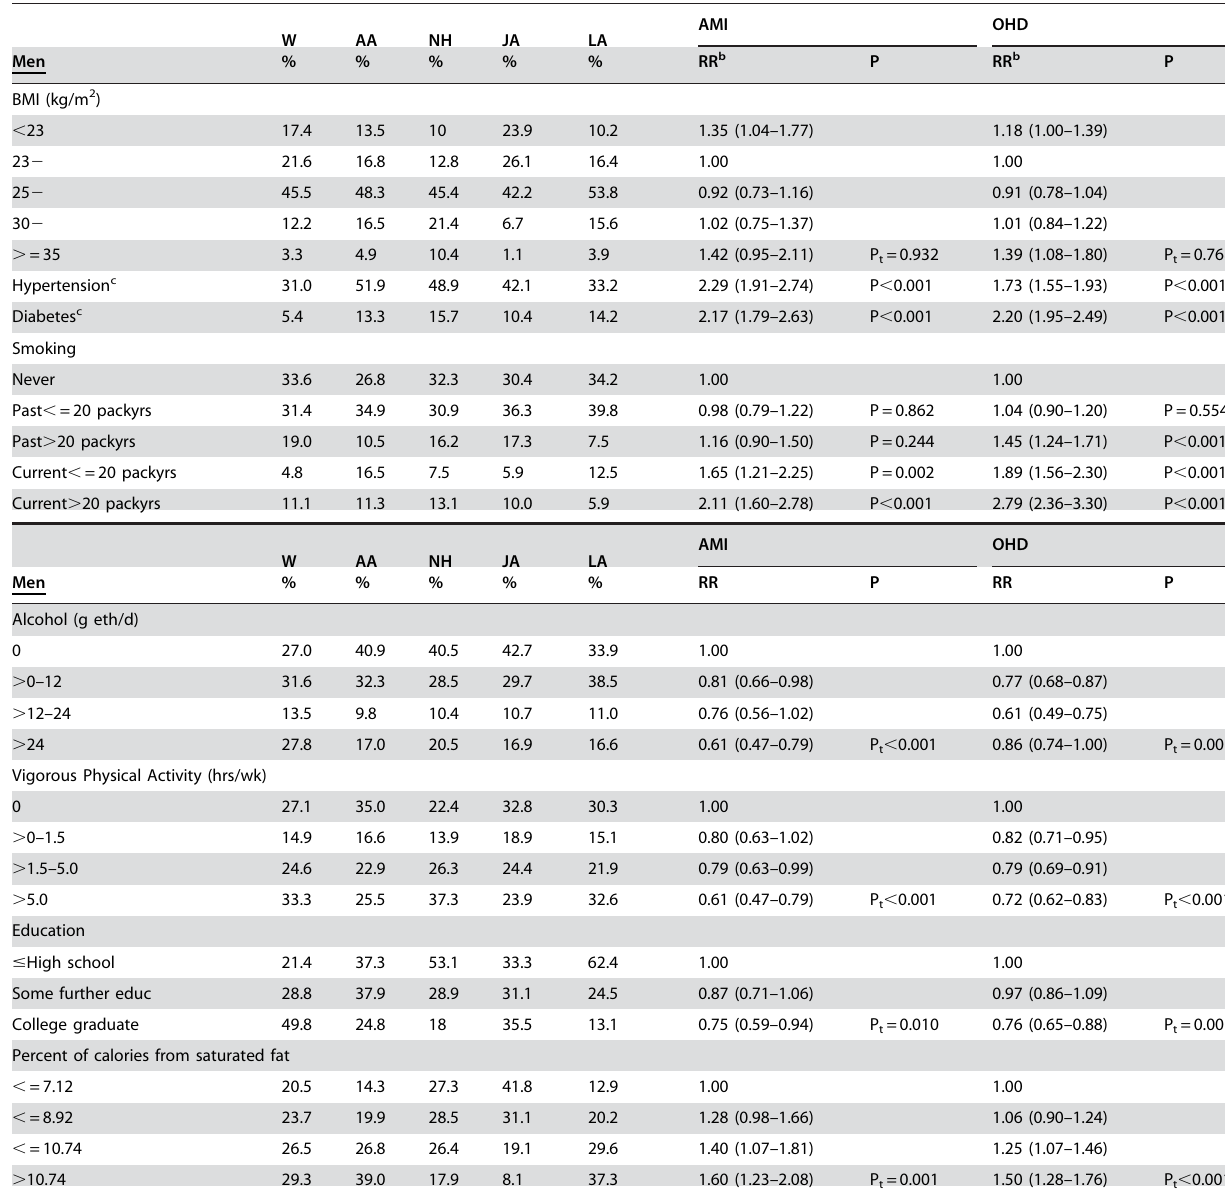
Table 2. Age-standardized a distributions of risk factors with associated RRs of mortality from AMI and OHD among men in the MEC. .. ... .... ... ... .... ... ... .... ... ... .... ... ... .... ... ... .... ... ... .... ... ... .... ... ... .... ... ... .... ... ... .... ... ... .... ... ... .... ... ... .... ... ... . W AA